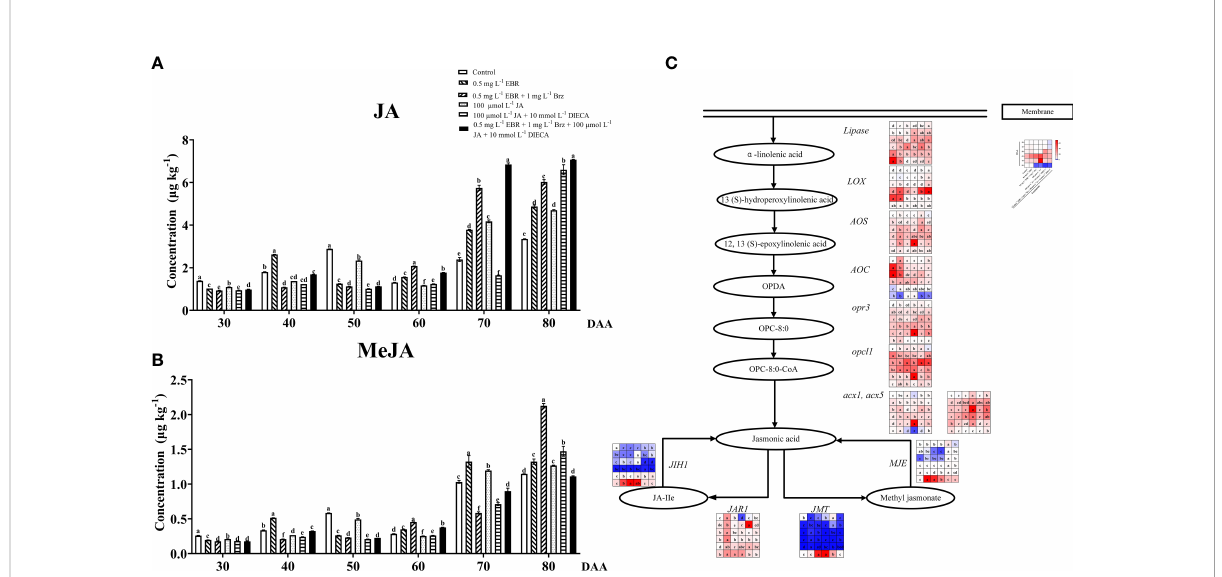
FIGURE 6 Effect of exogenous EBR, JA and their signaling inhibitors on JA/MeJA biosynthesis and metabolism. (A, B) Effect of exogenous EBR, JA and their signaling inhibitors on JA/MeJA contents in different treatment groups (Control, 0.5 mg L -1 EBR, 100 m mol L -1 JA, 0.5 mg L -1 EBR + 1 mg L -